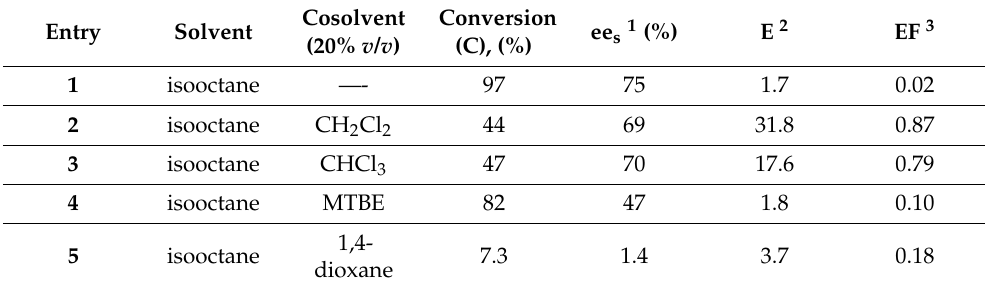
Table 1. Effect of organic polar cosolvents on the kinetic resolution of rac -ibuprofen.